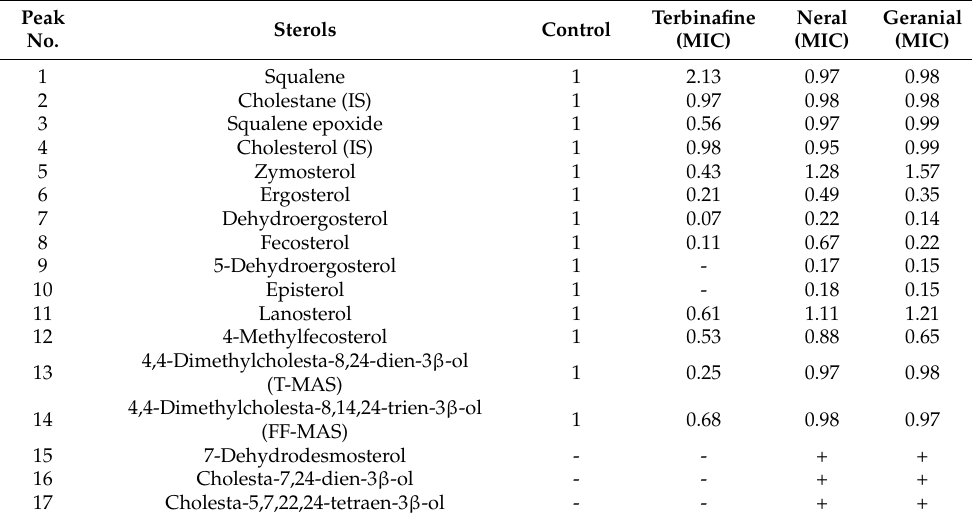
Table 2. Sterol pattern change of ergosterol biosynthesis pathway in Trichophyton rubrum conidia treated with specific agents for five